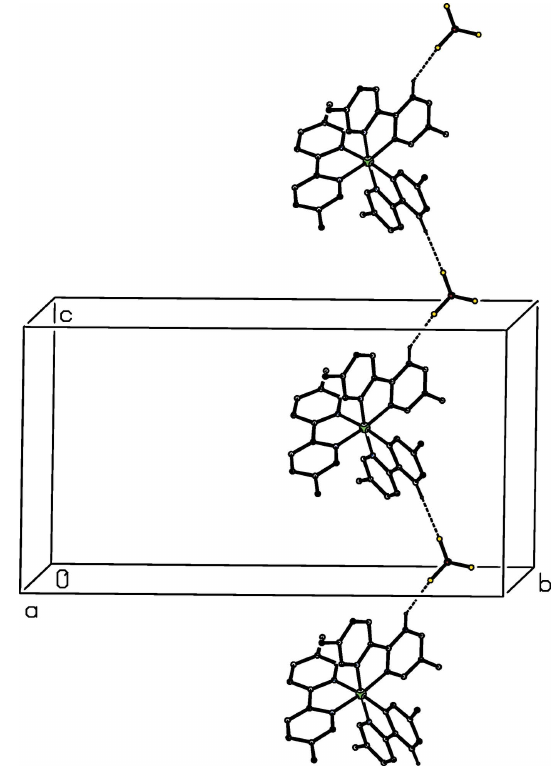
Figure 10 Part of the crystal structure of compound (III) showing the formation of a hydrogen-bonded C 2 (12) chain running parallel to the [001] direction. 2 For the sake of clarity, the tcnome anion, the ethanol component and the H atoms not involved in the motif shown have been omitted.